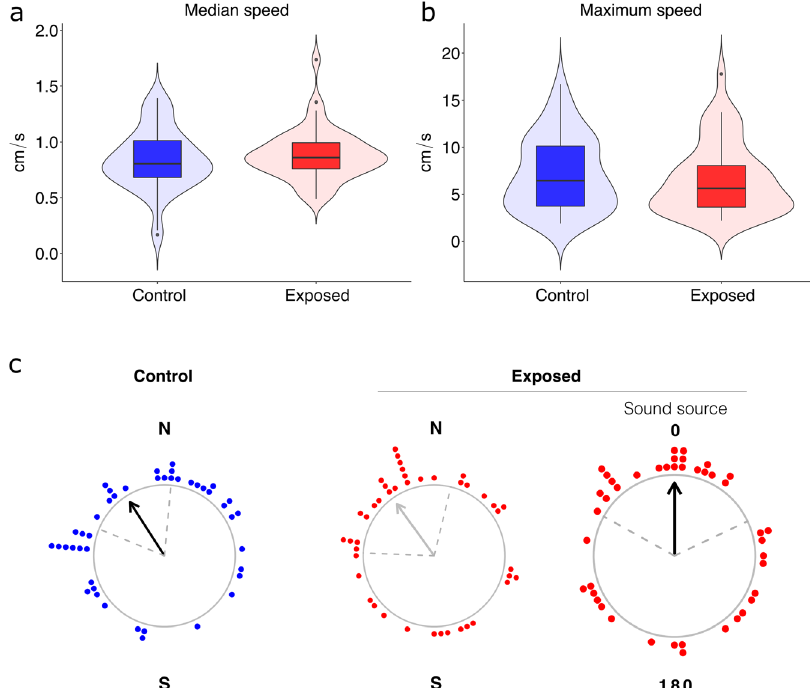
Fig. 6 Swimming speed and orientation behavior of Atlantic cod ( Gadus morhua ) larvae in the drifting chambers. Boxplots show minimum, 25th percentile, median, 75th percentile, and maximum values, in the Control and Exposed groups. a Median routine swimming speed (Control: N = 44; Exposed: N = 45). b Maximum swimming speed (Control: N = 44; Exposed: N = 45). c Orientation of the signi fi cantly orienting larvae (larvae that showed an individual preferred orientation; N = 87) from the Control group (blue points; N = 44) and Exposed group (red points; N = 43) with respect to the magnetic north (N) and south (S), and orientation of the Exposed larvae corrected to the direction of the 100 Hz continuous sound source (C-Bass M72- 110) (sound source). Correction to the direction of the sound source was performed on the tracks of each individual larva, every second, by using the relative direction sound source-chamber from the GPS data. Each point corresponds to the mean bearing of one cod larva in situ (averaged over 600 data points from the video tracks, Fig. S1). The arrow points toward the mean angle of all the individual bearings. The arrow is black when the orientation is signi fi cant ( p < 0.05), as in the larvae from the Control group (Rayleigh ’ s test of uniformity, mean bearing in situ = 327°, r = 0.33, p = 0.006). The black arrow points towards the de fi ned mean direction of 0° (sound source) in the plot showing the orientation of the Exposed larvae with respect to the sound source (Rayleigh test with the speci fi ed mean direction of 0°, N = 43, r = 0.23, p = 0.015). The arrow is gray in the plot of the orientation of exposed larvae with respect to the magnetic north as the orientation direction is close to signi fi cant ( N = 43, mean direction = 324°, r = 0.26, p = 0.051). Dashed gray lines are the 95% con fi dence intervals around the